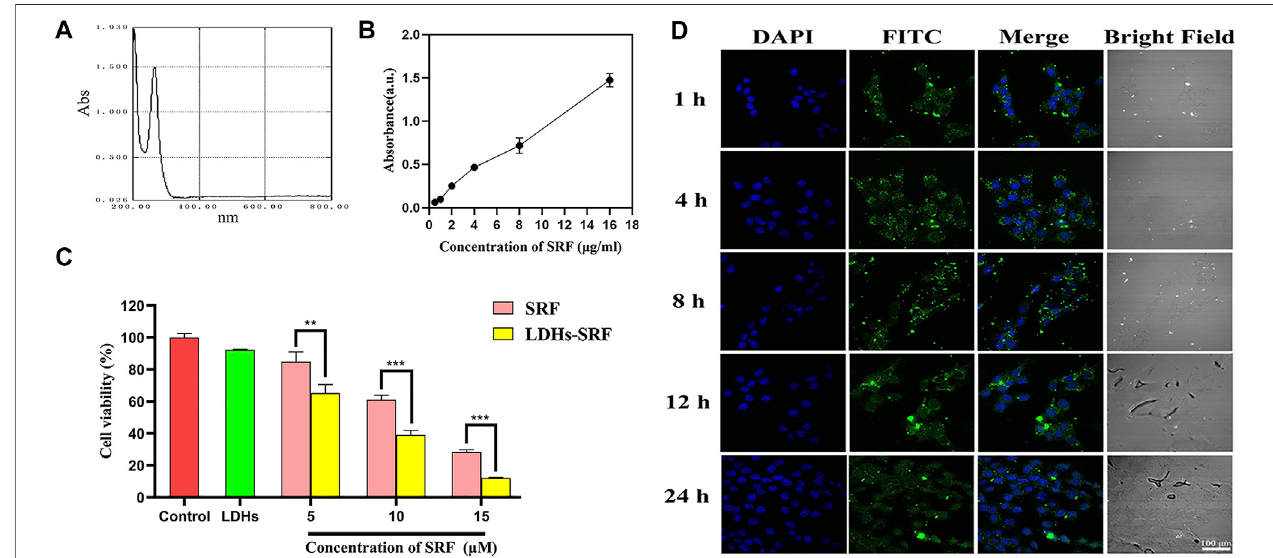
FIGURE 2 | Cell proliferation ability and cellular uptake of LDHs-SRF in HSC-T6 cells. (A) Ultraviolet full wavelength scanning curve of SRF; (B) Correction curve of SRF in methanol; (C) CCK8 analysis of the cell viability of HSC-T6 treated with sorafenib, LDH, and LDHs-SRF after 24 h treatment. Data are expressed as mean ± SD ( n = 3) and use one-way ANOVA with Tukey ’ s multiple comparison test, ** p < 0.01, *** p < 0.001; (D) Confocal images of LDHs-SRF (stained with FITC) and nucleus (DAPI) at different time points. (Scale bar = 100 μ